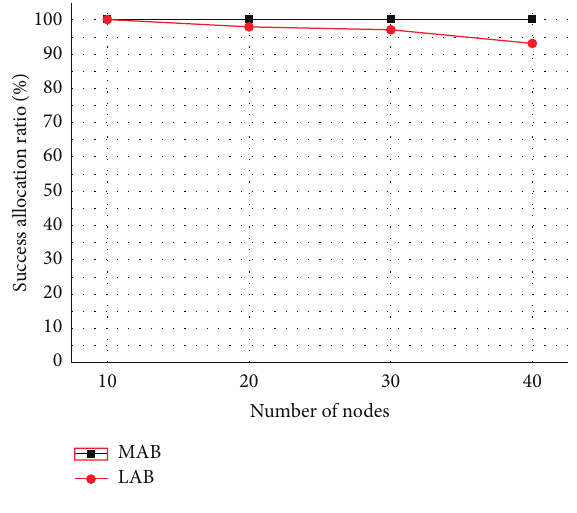
Figure 15: Successful allocation ratio.